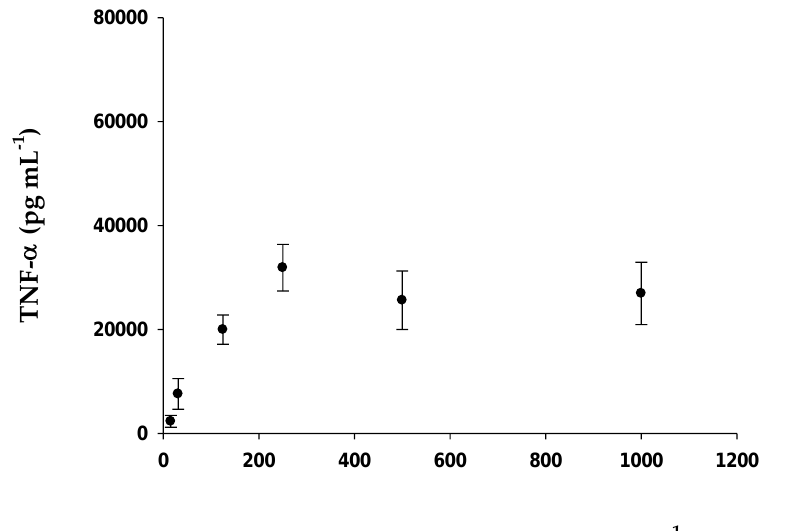
Figure 10. Concentration of Tumor Necrosis Factor- α by HPT-1 exposed to different concentrations of EgPs. Data are the mean SD of three independent experiments.